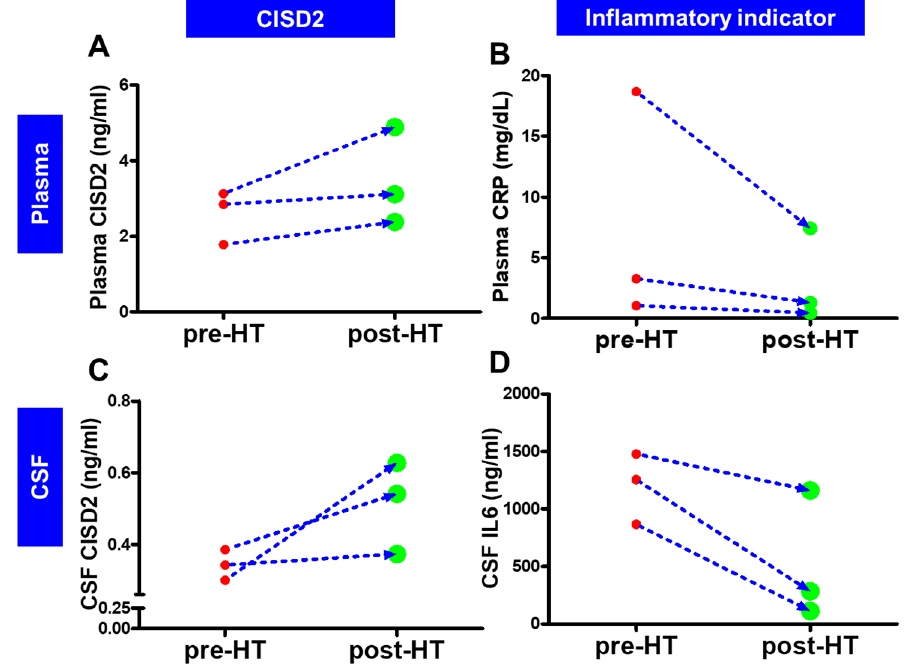
Figure 6. Three patients with central nervous system (CNS) injury (cases 2, 12, and 13; Table 1) who underwent decompression surgery were subjected to targeted temperature management (TTM) immediately after the surgery. The plasma ( A ) and cerebrospinal fluid (CSF) ( C ) levels of CISD2 after TTM were higher than those before TTM. The plasma CRP levels ( B ) and the CSF IL6 levels ( D ) after TTM were significantly lower than those before TTM. The prognostic assessment of the three patients after therapeutic hypothermia treatment revealed that TTM mitigated inflammation. The levels of anti-inflammatory CISD2 increased after TTM, which demonstrated that CISD2 is a biomarker for CNS insult.